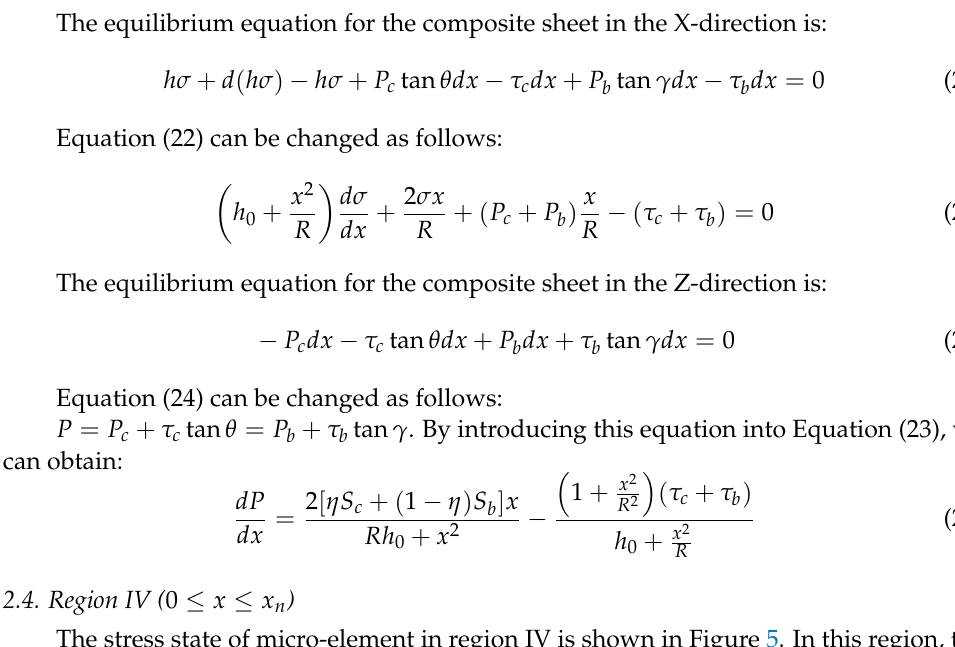
Figure 4. Stress state of micro-element in region III.